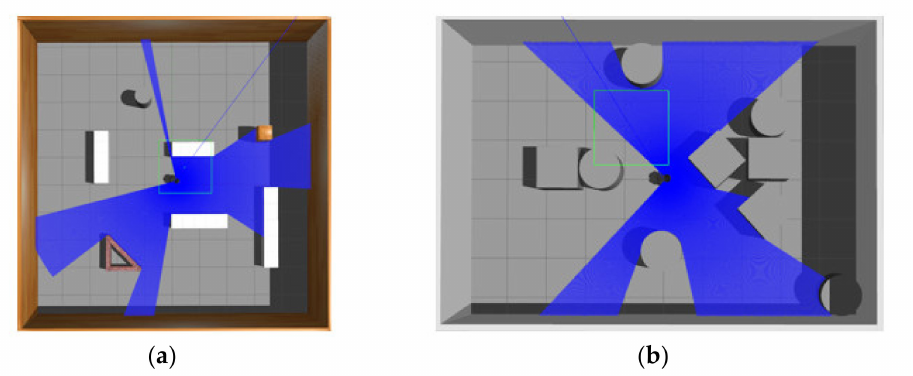
Figure 8. The training and testing environments for navigation task. ( a ) training environment ( b ) testing